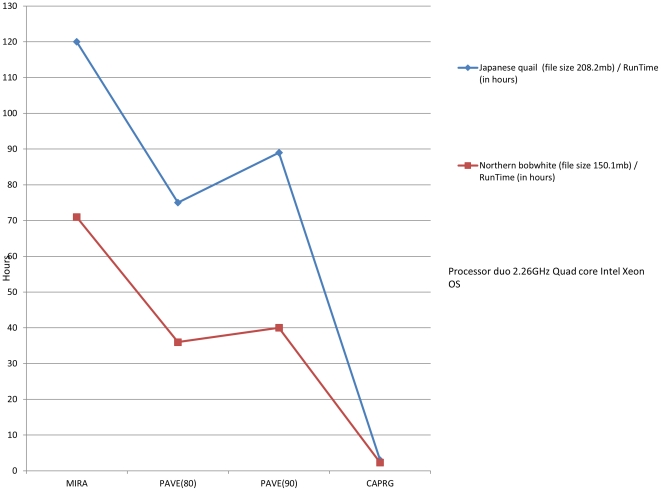
Runtime for each program.Assembly times represent execution on a computer with a duo 2.26 GHz Quad core Intel Xeon processor, 16 GB of RAM and 64 bit Snow Leopard v1.6 operating system.